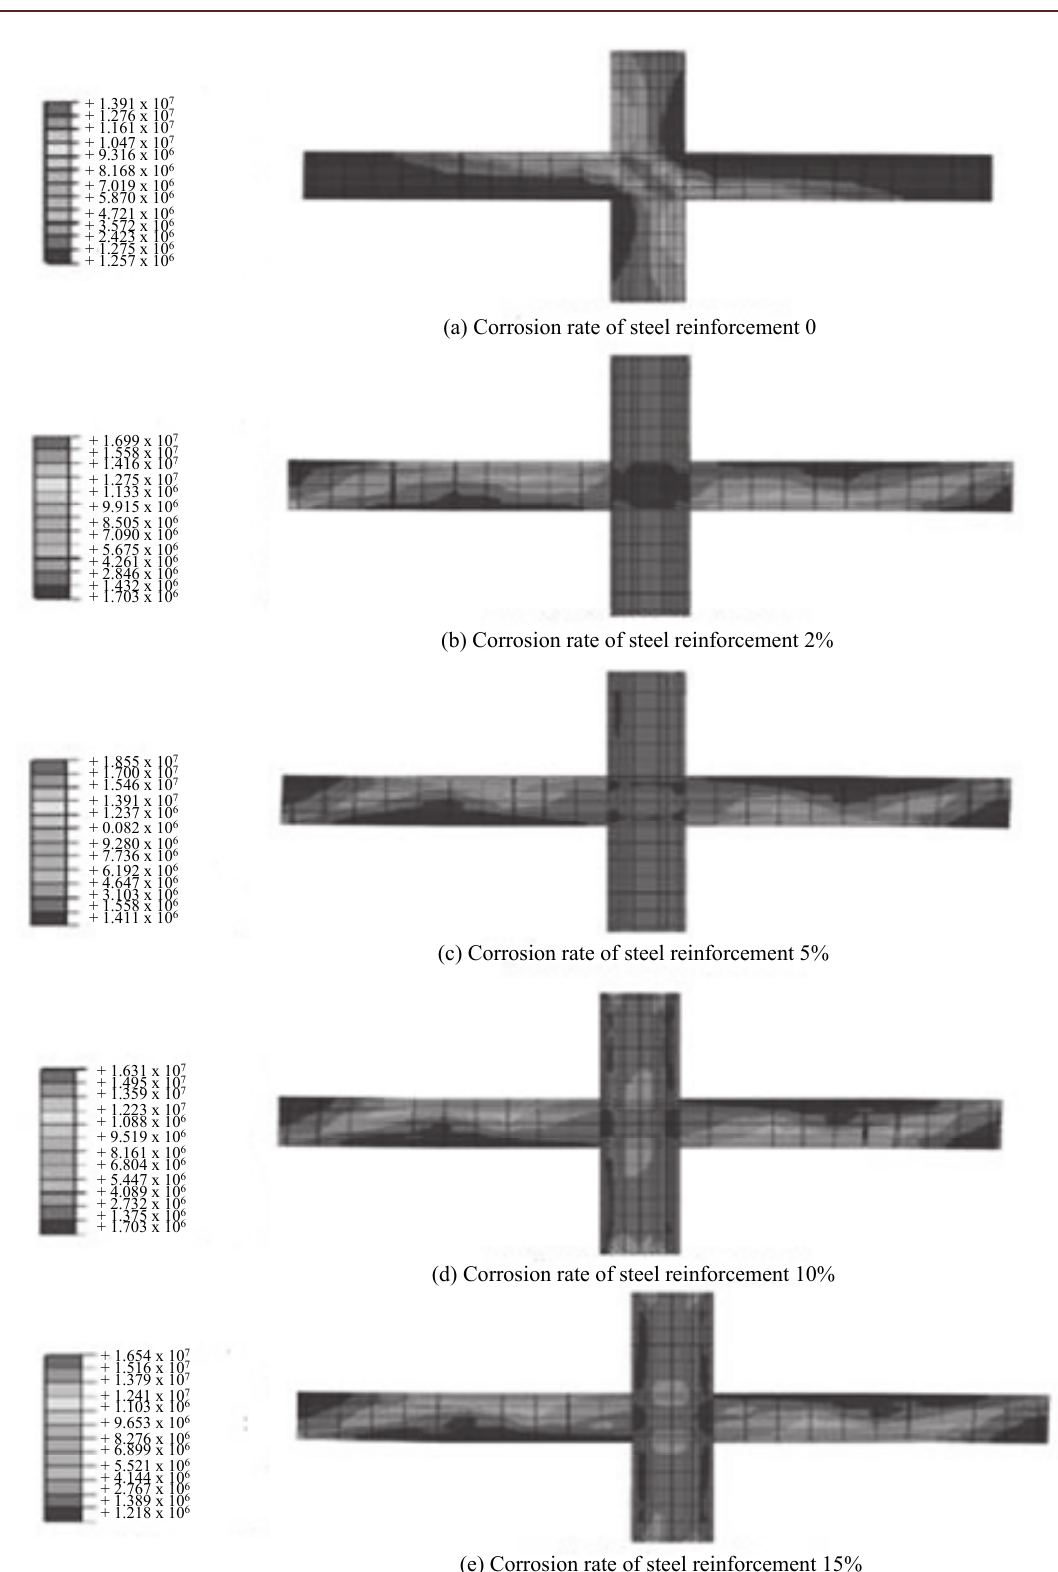
Figure 7: Nephogram of stress on joints of